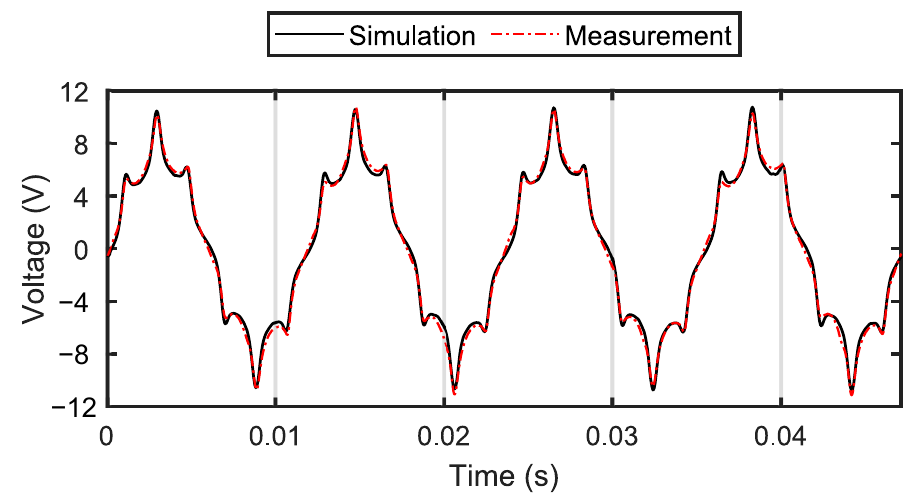
Figure 9. Induced phase voltage for a field current of i f = 4.8 A parallel connected. However, a series connection forces the current to be the same in each field coil, avoiding demagnetization, and producing an induced voltage nearly two times higher as compared to the parallel connection, as shown in Figure 10. The fundamental waveform is 82.5% higher, which increases the output power by 3.3 times.